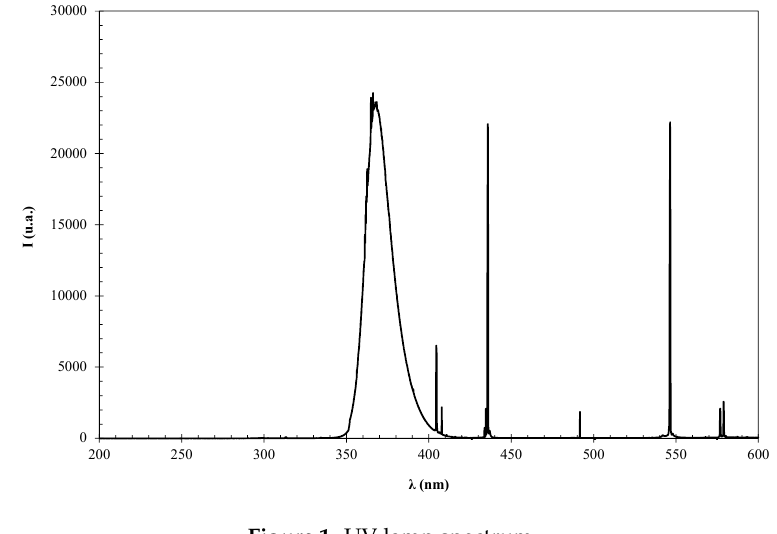
Figure 1. UV lamp spectrum.